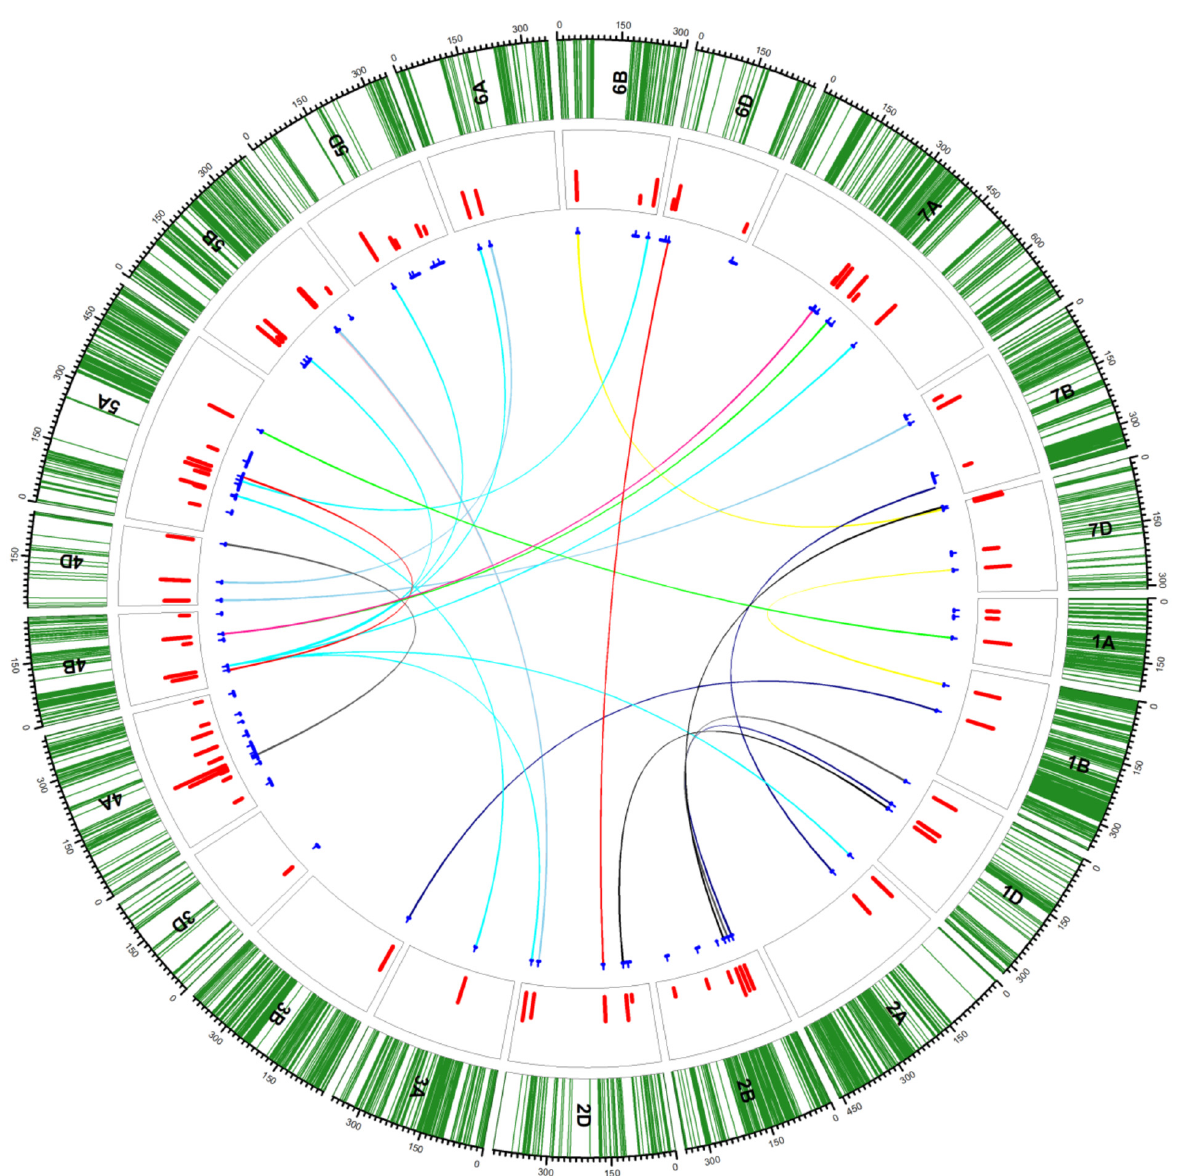
Figure 1. Circos diagram showing the presence of additive (unconnected blue lines in the inner circle) and epistatic (connected blue lines in inner circle) QTLs. Green lines in the outer track indicate the SNP positions on each chromosome; red bars in the second circle indicate the LOD values of QTLs. The blue lines under the track circle indicate the confidence interval of QTLs with small vertical lines point to the peak position of QTL. The colored lines linked different biallelic epistasic QTLs (yellow, pink, sky blue, navy blue, aqua, black, deep pink and red indicate traits related to seed longevity in either control or after various treatments and green and grey and grey indicate dormancy related loci. The figure is reproduced from [117].